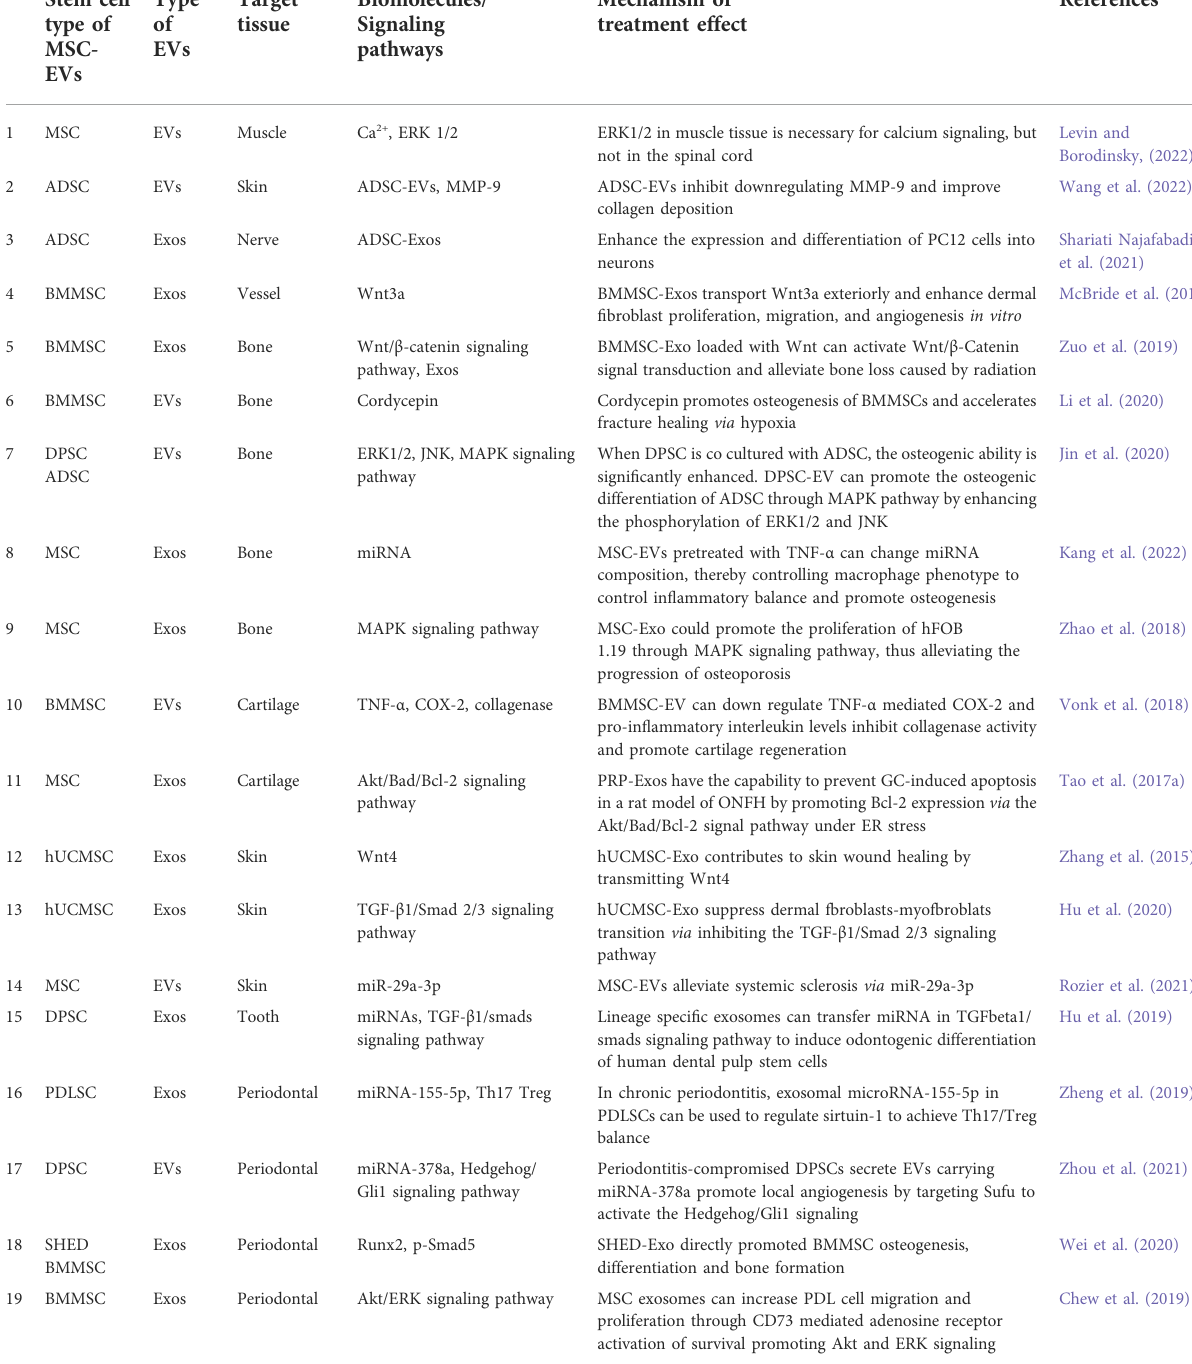
TABLE 2 Effects of MSC-EVs in various tissue repair and regeneration relevant to oral and craniomaxillofacial